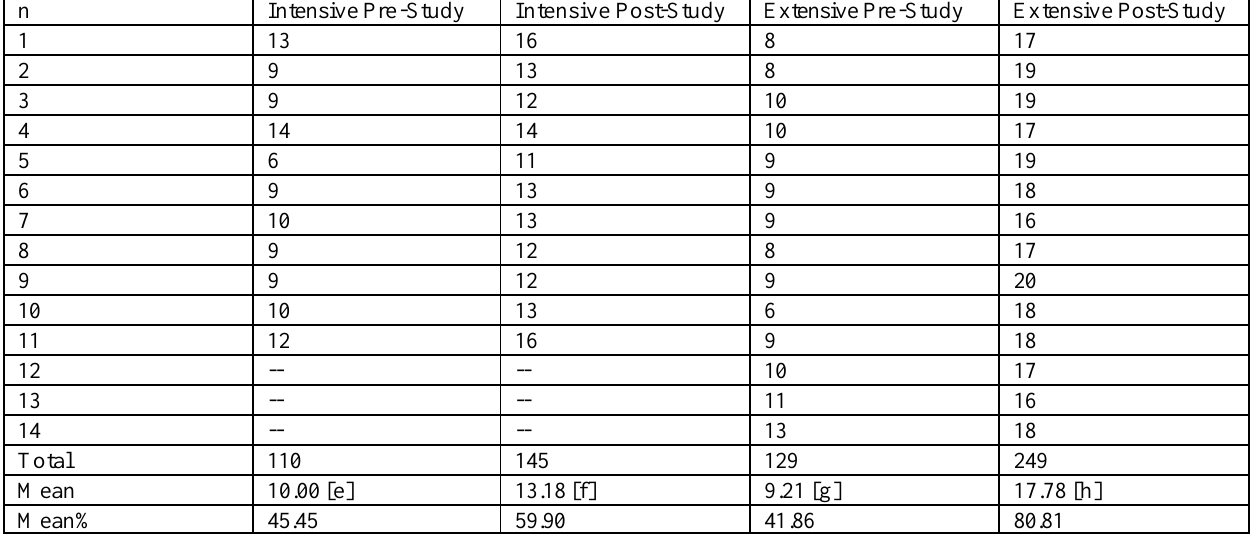
Table 4.8 Combined Scores of Multiple Choice and True/False